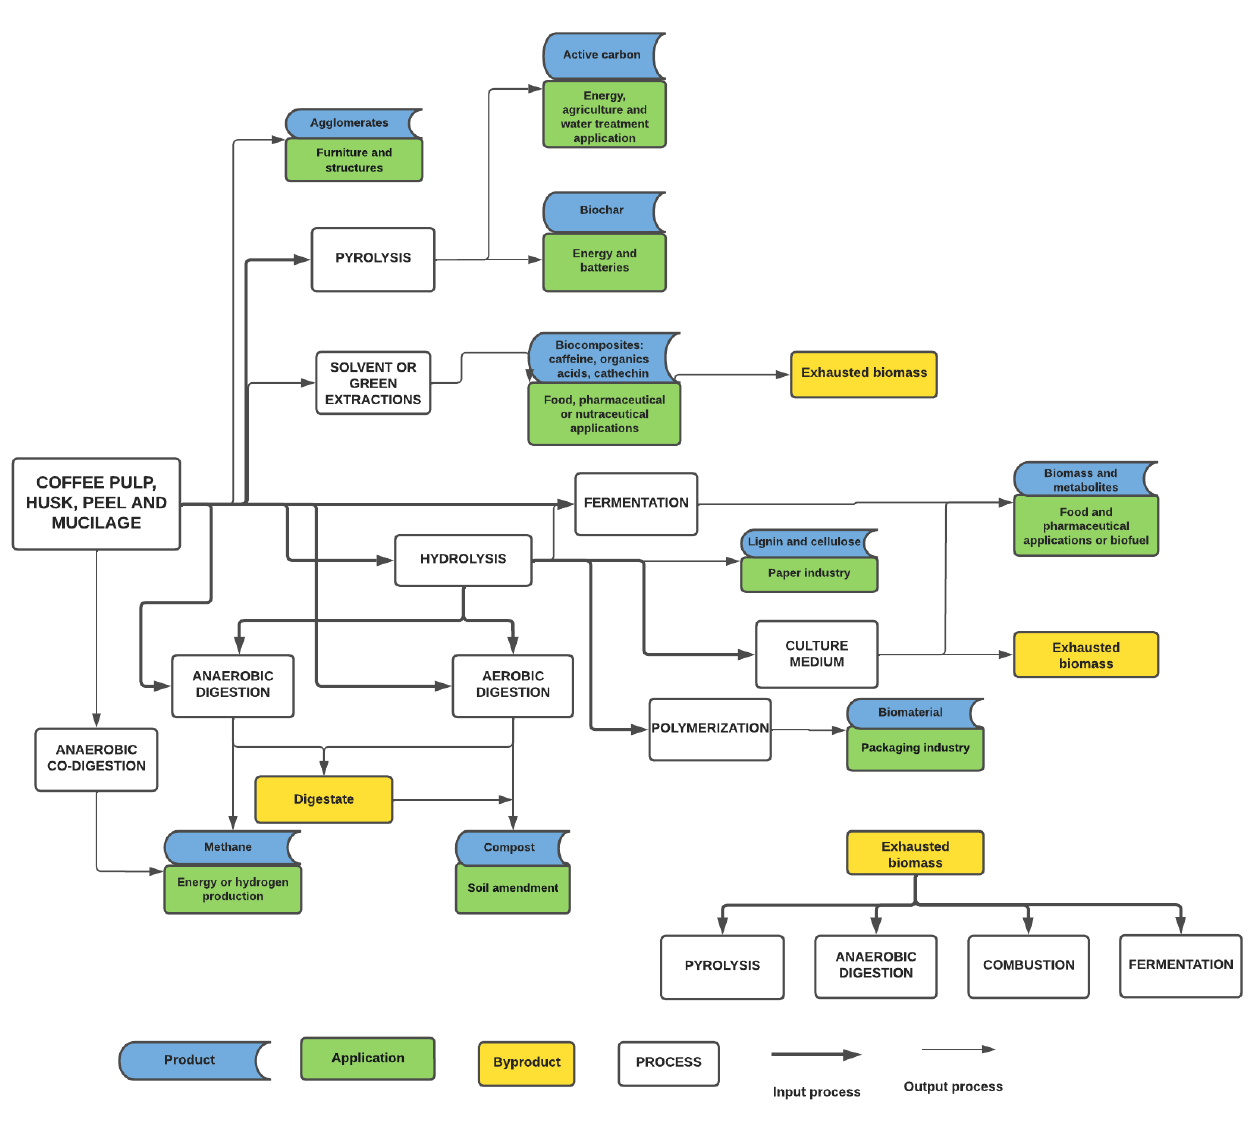
Figure 5. Possible biorefinery routes for valorizing wastes and by-products derived from primary coffee processing.